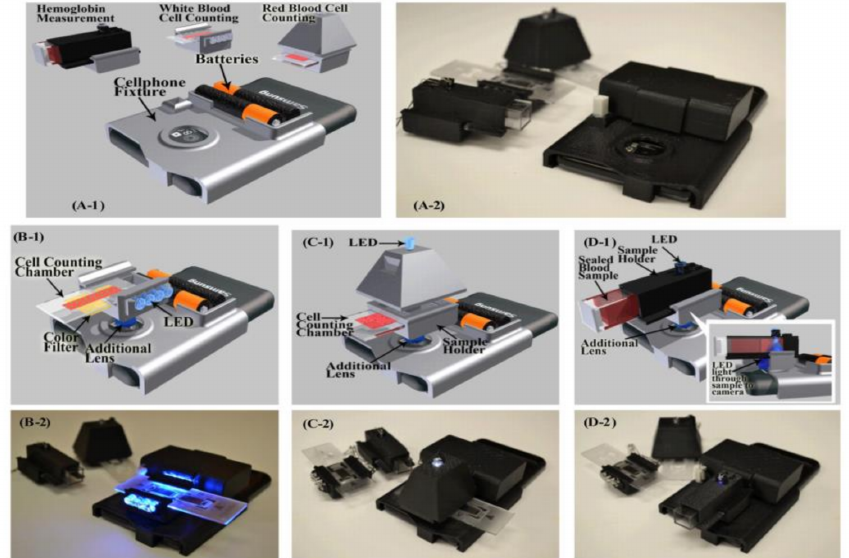
Figure 15. ( A1 , A2 ) Illustration and picture of our cell-phone based blood analysis platform. ( B1 , B2 ) Setup for white blood cell counting device. ( C1 , C2 ) Setup for red blood cell counting device. ( D1 , D2 ) Setup for a hemoglobin measurement device. Figure adapted with permission from [22].